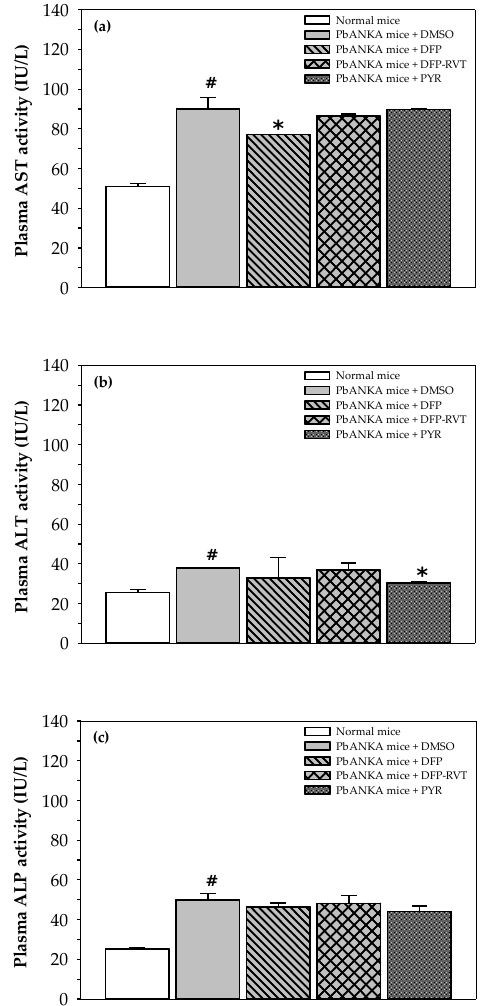
Figure 4. Levels of AST, ALT and ALP activities in plasma collected from normal mice and PbANKA-infected mice treated with DMSO, DFP, DFP-RVT and PYR. ( a ) Plasma AST activity, ( b ) Plasma ALT activity, and ( c ) Plasma ALP activity. Male ICR mice were infected ip with PRBC suspension (1 × 10 7 cells/mL with 5–20% parasitemia), then orally administered with 60% DMSO, PYR (2 mg/kg BW), DFP (50 mg/kg BW) and DFP-RVT (50 mg/kg BW) every day for 4 d. The mice were then humanely euthanized. Heart blood was collected into lithium heparin-coated tubes and plasma was separated for analysis of aspartate aminotransferase (AST), alanine aminotransferase (ALT) and alkaline phosphatase (ALP) activities. Data are expressed as mean ± SEM values. # p < 0.05 when compared to normal mice; * p < 0.05 when compared to PbANKA mice treated with DMSO.